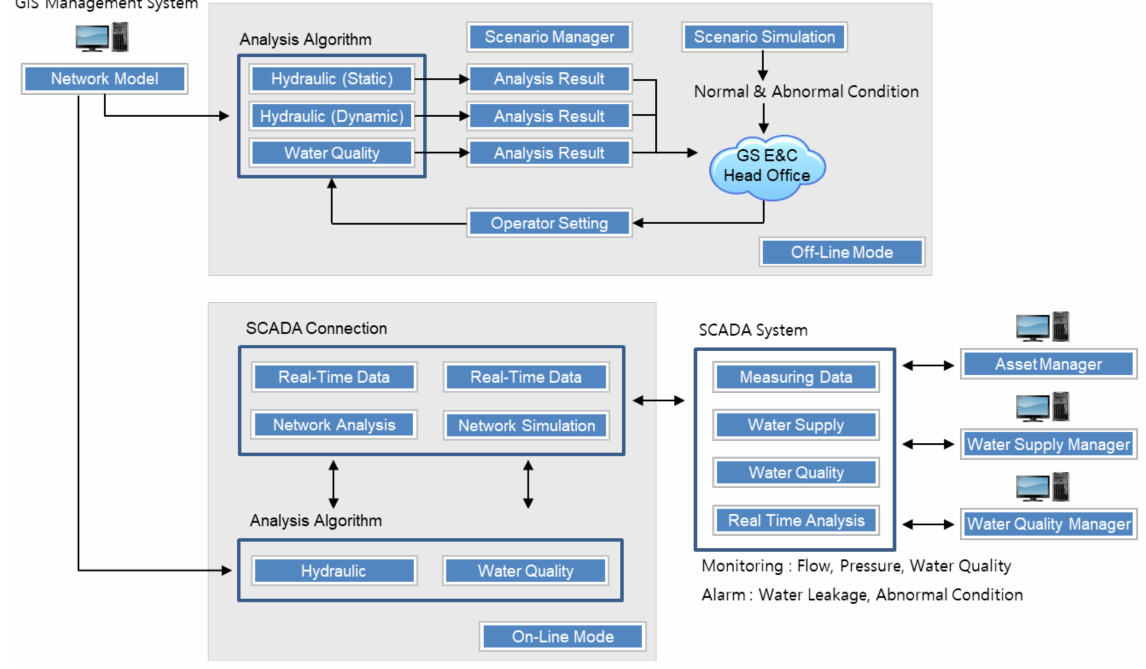
Figure 2. Functional diagram of the network system in